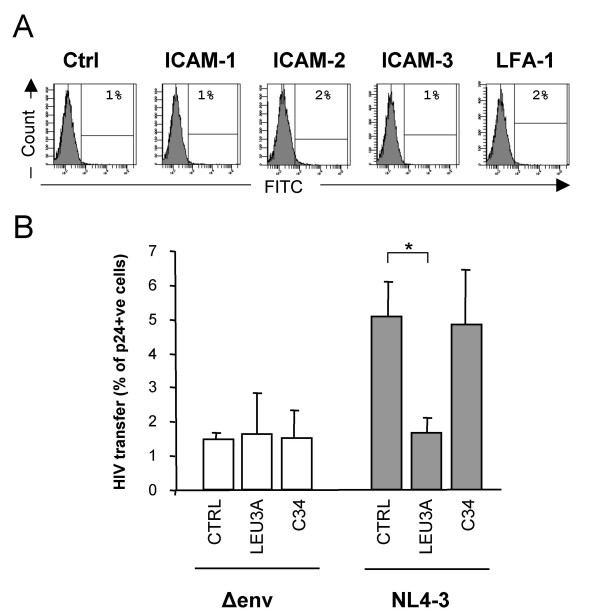
LFA-1 independent cell-to-cell HIV transmission. Panel A depicts the expression of the indicated adhesion molecules on the surface of the 293T cell line. The percentage of positive cells is indicated in each histogram. Control histogram corresponds to background of staining. Panel B shows HIV transfer from 293T cells, transfected to produce HIV particles, to target CD4 T cells in the absence (light bars) or presence (grey bars) of NL4-3 Env expression. The effect on the addition of blocking antibodies against CD4 (Leu3a) and the gp41 inhibitory peptide C34 was also tested. Data (Mean ± SD) were obtained using cells from 3 different donors. Asterisk indicates a significant inhibition in HIV transmission in the presence of Leu3a within NL4-3 Env transfected 293T cells.